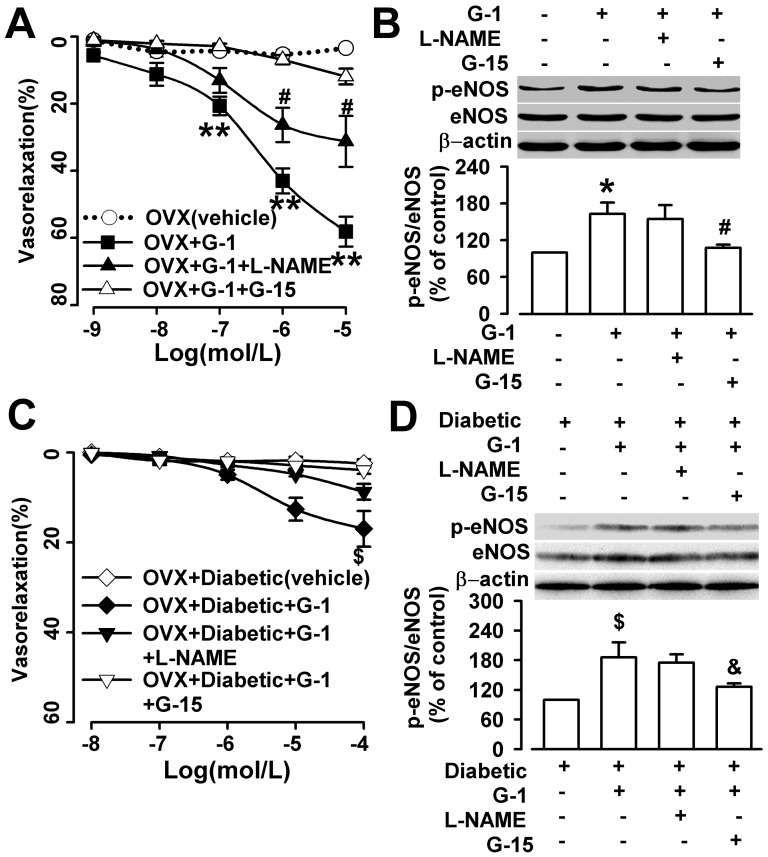
G1-induced relaxation in the thoracic artery in a dose-dependent manner.(A) G-1 (1 nM -10 µM) dilated the arteries from the OVX rats in a dose-dependent manner; however, L-NAME (100 µM) and G15 (1 µM) partially abolished the effect of G1. n = 6 rings from 3 rats. (B) G1 increased the phosphorylation level of eNOS (p-eNOS; at serine1177) in arteries from OVX rats, and the phosphorylation level of eNOS induced by G1 was partially attenuated by G15. (C) G-1 (10 nM -100 µM) dilated the arteries from the diabetic OVX rats in a dose-dependent manner; however, L-NAME (100 µM) and G15 (1 µM) abolished the effect of G1. n = 6 rings from 3 rats. (B) G1 increased the phosphorylation level of eNOS (p-eNOS; at serine1177) in arteries from diabetic OVX rats, and the phosphorylation level of eNOS induced by G1 was partially attenuated by G15. *
p<0.05 compared with OVX rats; #
p<0.05 compared with OVX+G1 rats; $
p<0.05 compared with diabetic OVX rats; **
p<0.01 compared with OVX rats; &
p<0.05 compared with diabetic OVX+G1 rats. Results are given as the mean ± SEM of three independent experiments.